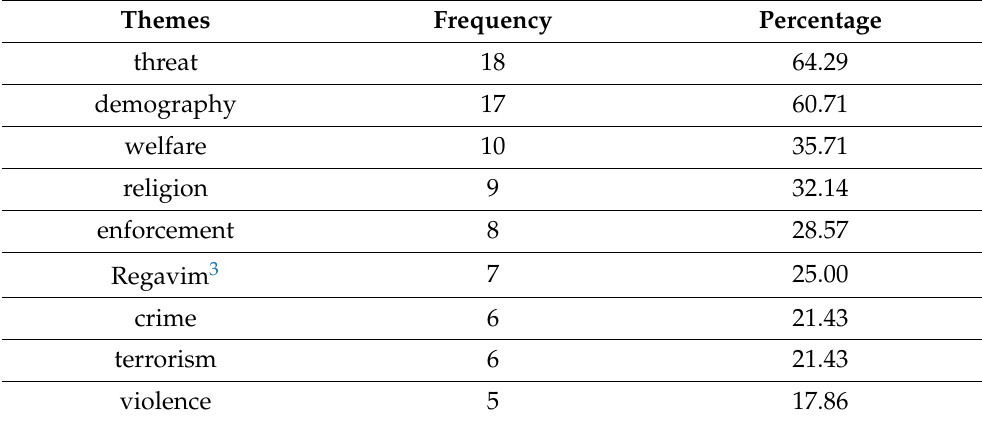
Figure 2. Voice by Newspaper. Table 2. Arutz